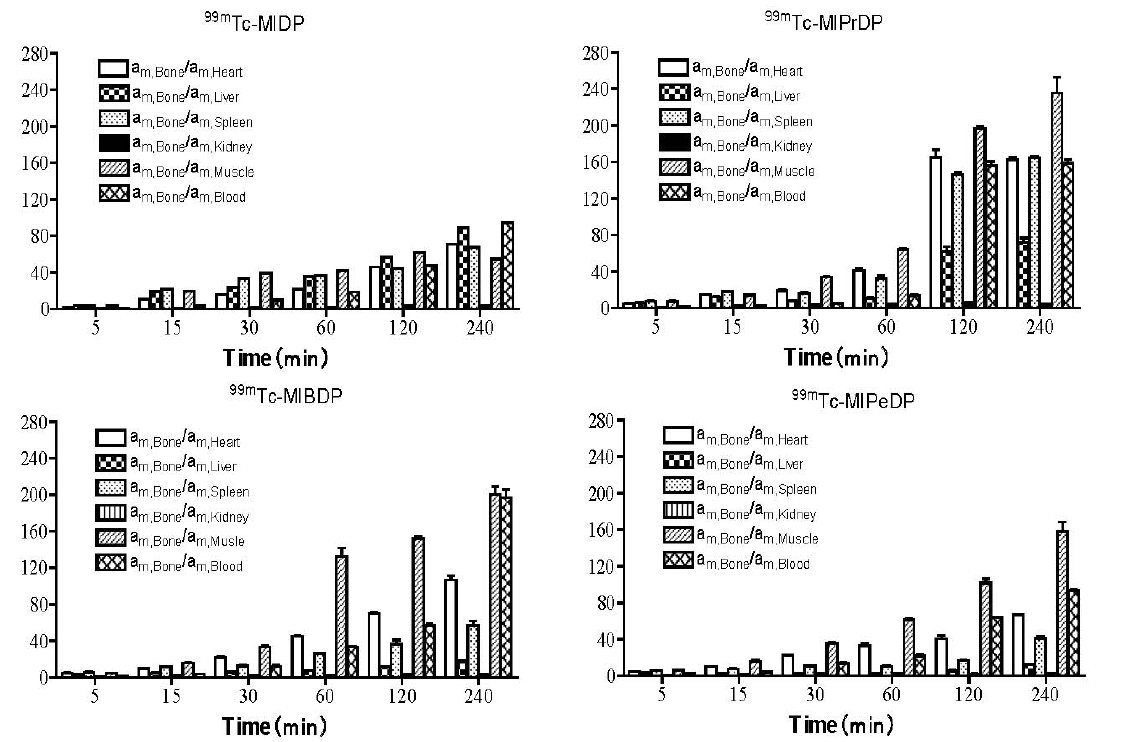
Figure 4. Bone to tissue uptake ratio in mice at different time post injection of 99m Tc-MIDP and 5a-5c